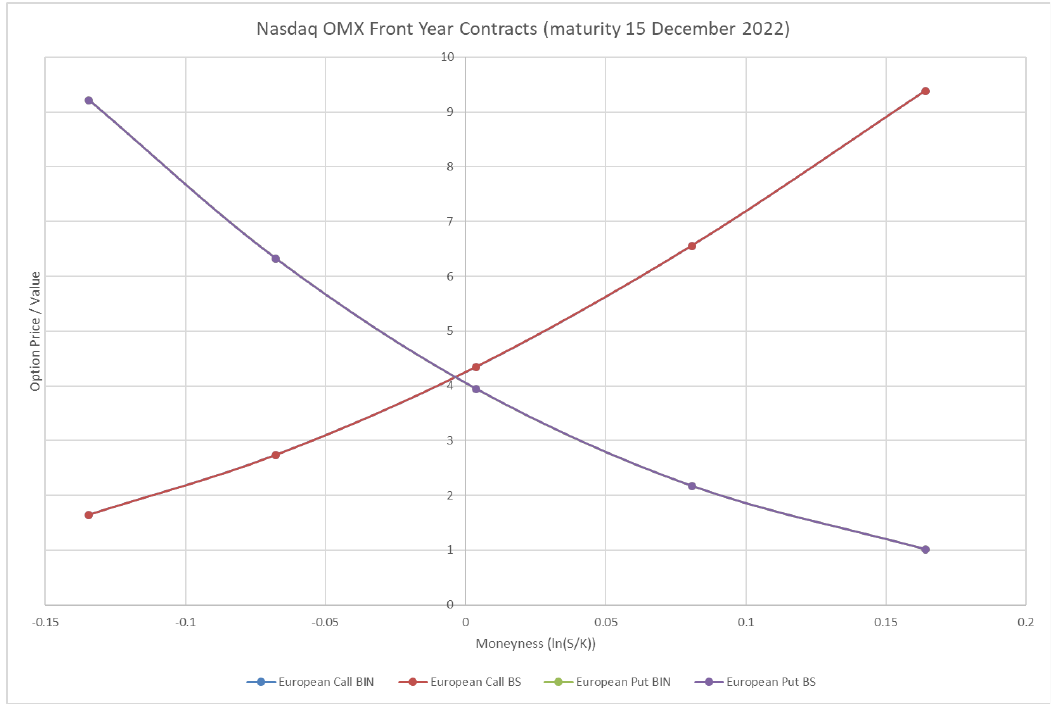
Figure 5. Option Prices over Moneyness for the Front Year Contracts.